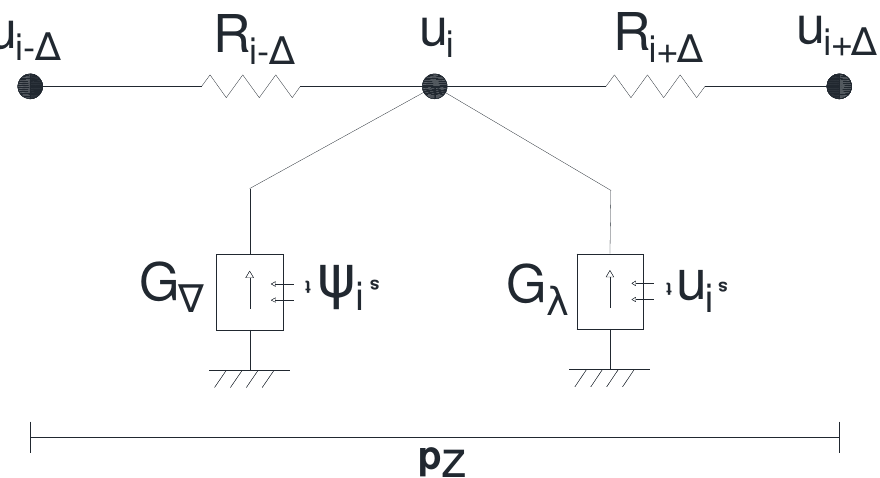
Figure 1. Nomenclature and network model of the volume element for variable u. Rectangular domains.